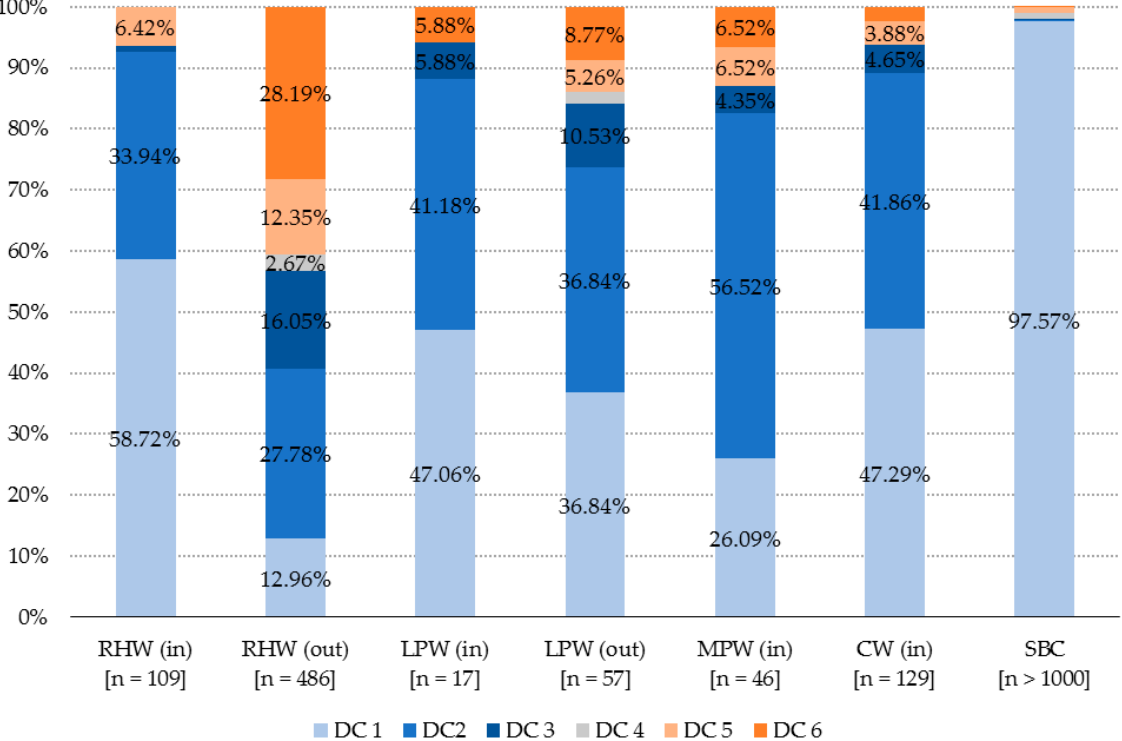
Figure 2. Distribution of damage degree according to the waste stream in which the batteries were found (Legend: RHW = residual household waste, LPW = lightweight packaging waste, MPW = metal packaging waste, CW = commercial waste, SBC = separate portable battery collection; values < 2% not displayed).